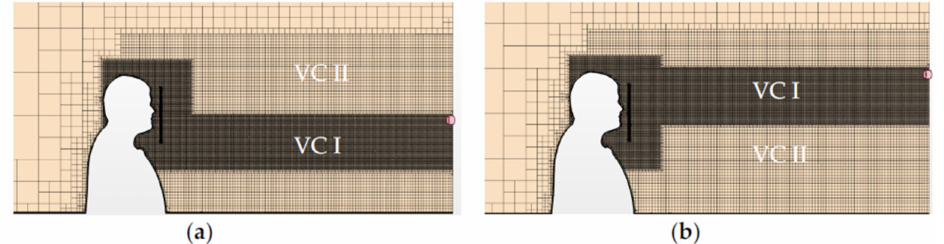
Figure 5. Mesh distribution, the block ( ) indicates the mouth of the individual that has the virus and sneezes: ( a ) The mesh in the domain when the mouths were at the same height; ( b ) The mesh in the domain when the mouths were at different heights (20 cm